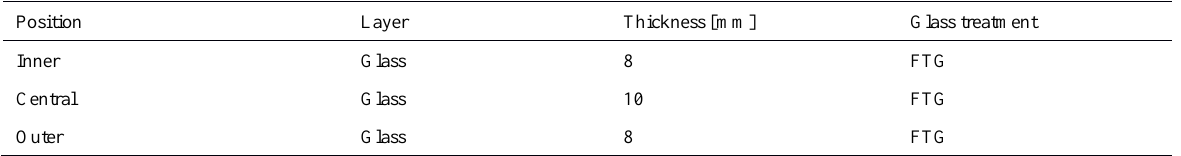
Table 2: Composition of the lateral laminated glass parapet.